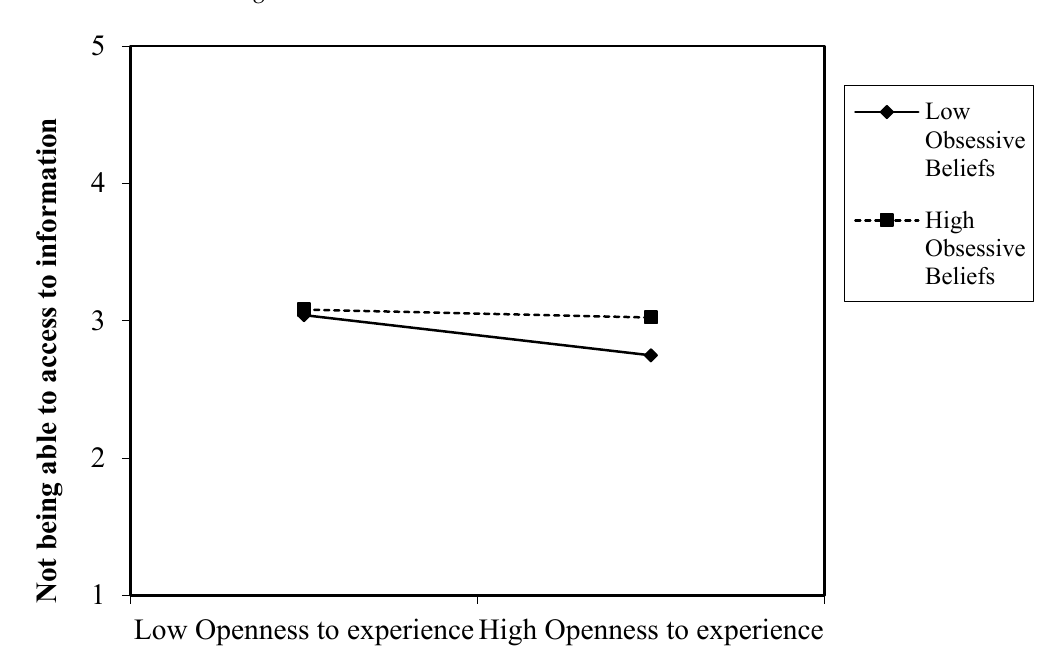
Figure 5. Interaction of openness to experience and obsessive beliefs in predicting the fear of not being able to access information.